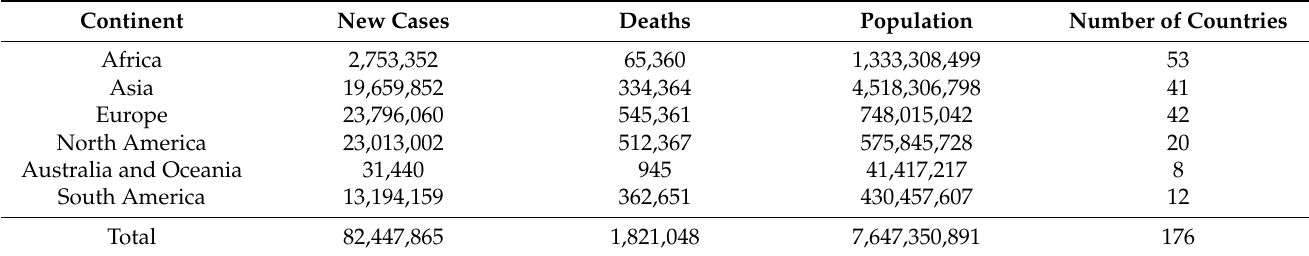
Table 1. Description of the study sample by continent.